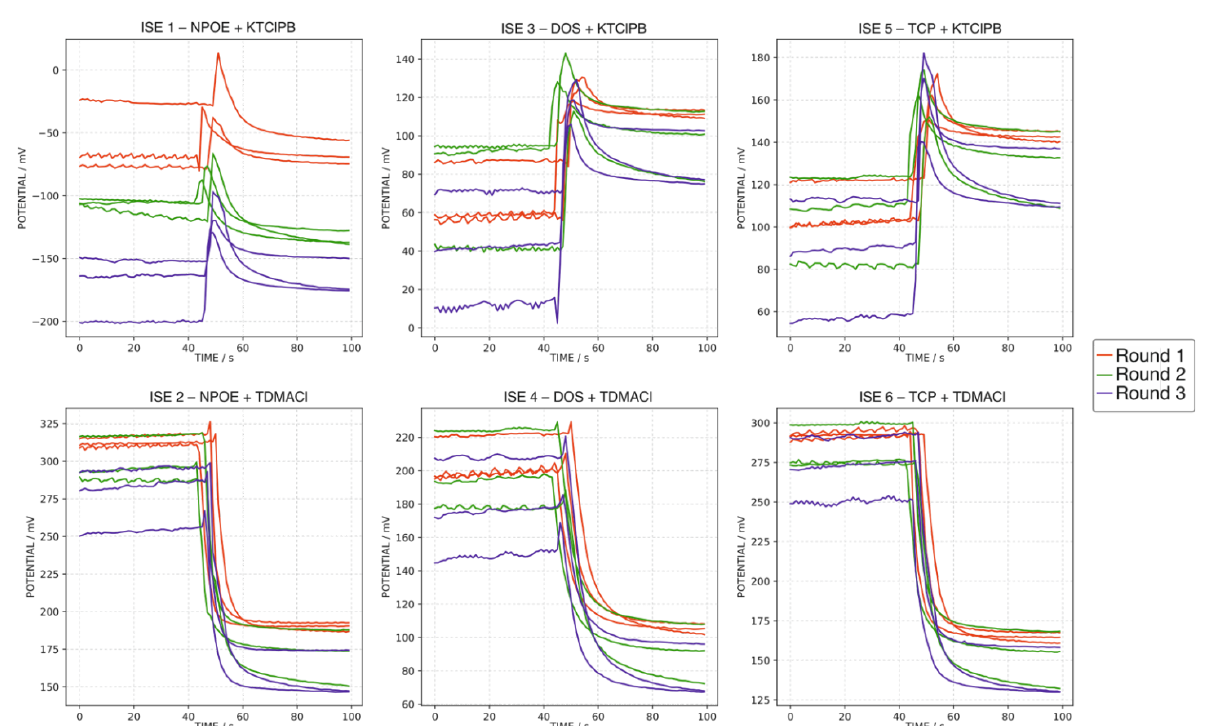
Figure 3. Triplicate dynamic potential responses of ISEs 1–6 observed for the MT sample at the beginning, middle and end of the entire experimental testing of the sample pool, applying the first measurement protocol (MilliQ water background).